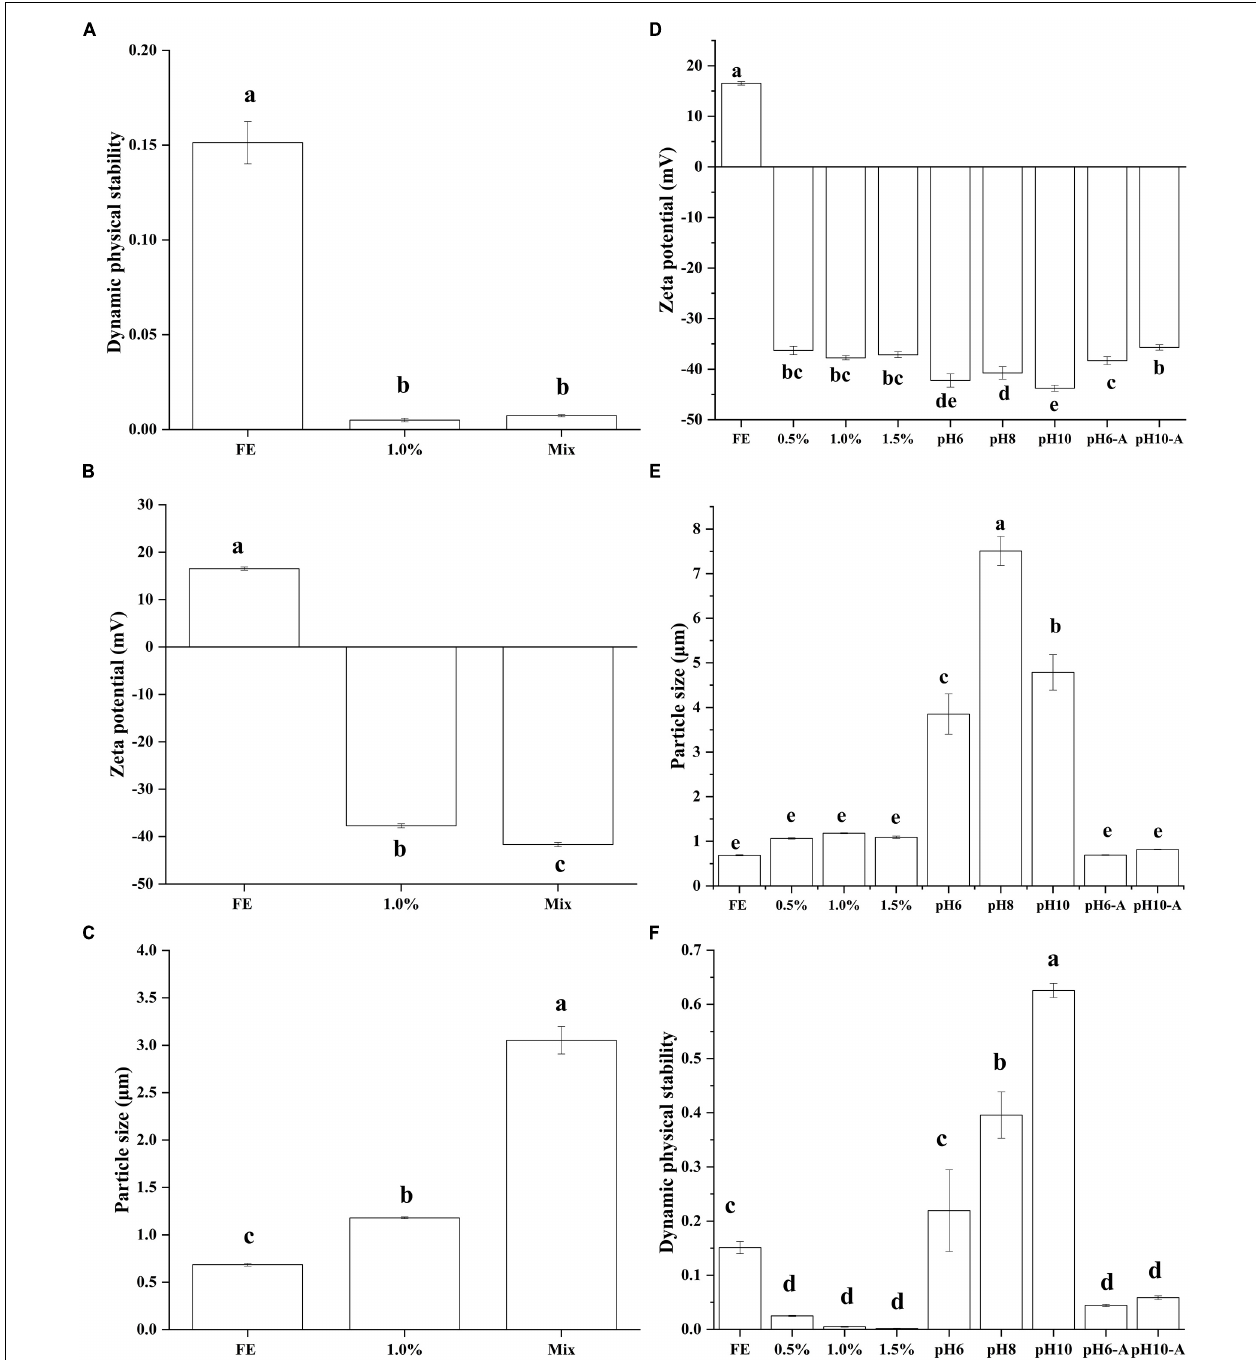
FIGURE 1 | Effect of preparation method on the dynamic physical stability (A) , zeta potential (B) , particle size (C) of complex emulsions; effect of pectin and pH on the zeta potential (D) , particle size (E) , and dynamic physical stability (F) of complex emulsions.